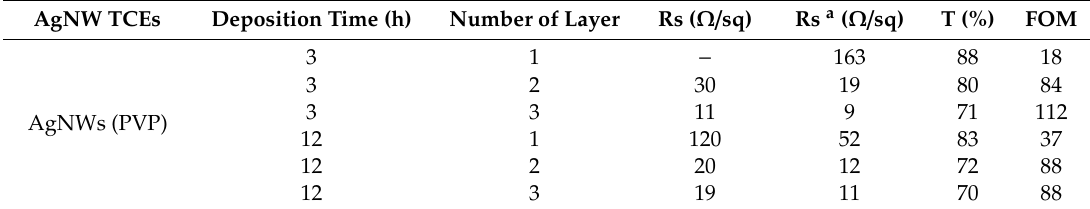
The sheet resistances and optical transmittances at visible region were utilized to evaluate for optoelectronic performance of AgNW films by calculating the figure of merit (FOM), which is the electrical to optical conductivity ratio ( σ DC / σ OP